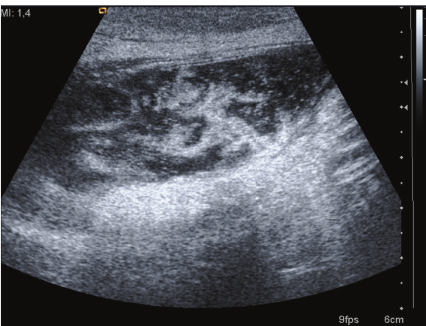
Figure 1: Abdominal wall transabdominal ultrasonography in longitudinal plane with linear probe in trapezoid format showed a mixed echogenicity, oval-shaped space occupying lesion with smooth borders which is situated in the abdominal wall of the left lower quadrant of the abdomen. The echogenic foci situated within the mass possibly represented